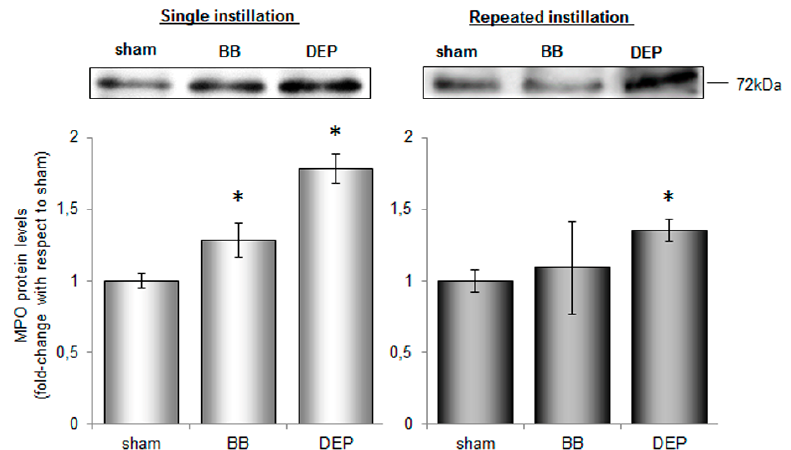
Figure 2. MPO protein levels in BALf after single and repeated instillations of BB and DEP. Representative immunoblotting images of MPO analysis in mice after single and repeated instillations with 50 µ g of BB or DEP / 100 µ L 0.9% NaCl. MPO data are indicated as fold-change with respect to sham. Proteins have been normalized for corresponding total proteins revealed by Ponceau staining in each lane and the data are expressed as mean ± standard error ( n = 6). Statistical differences were tested accordingly by One-way ANOVA followed by Bonferroni post-hoc comparison. * p < 0.05 vs. sham mice.